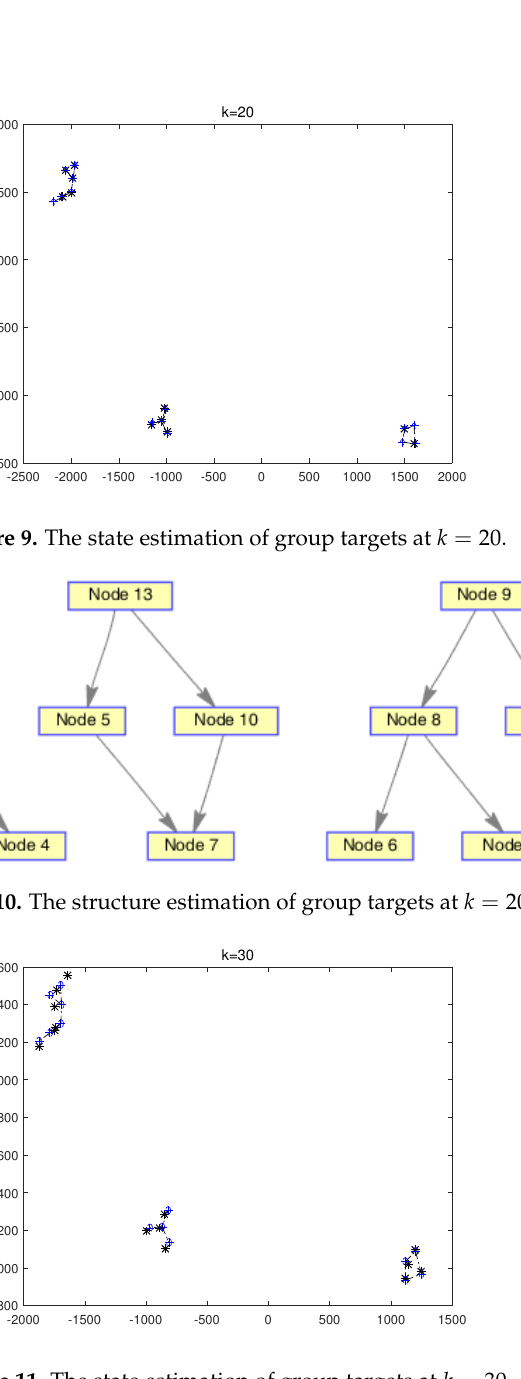
Figure 11. The state estimation of group targets at k = 30.